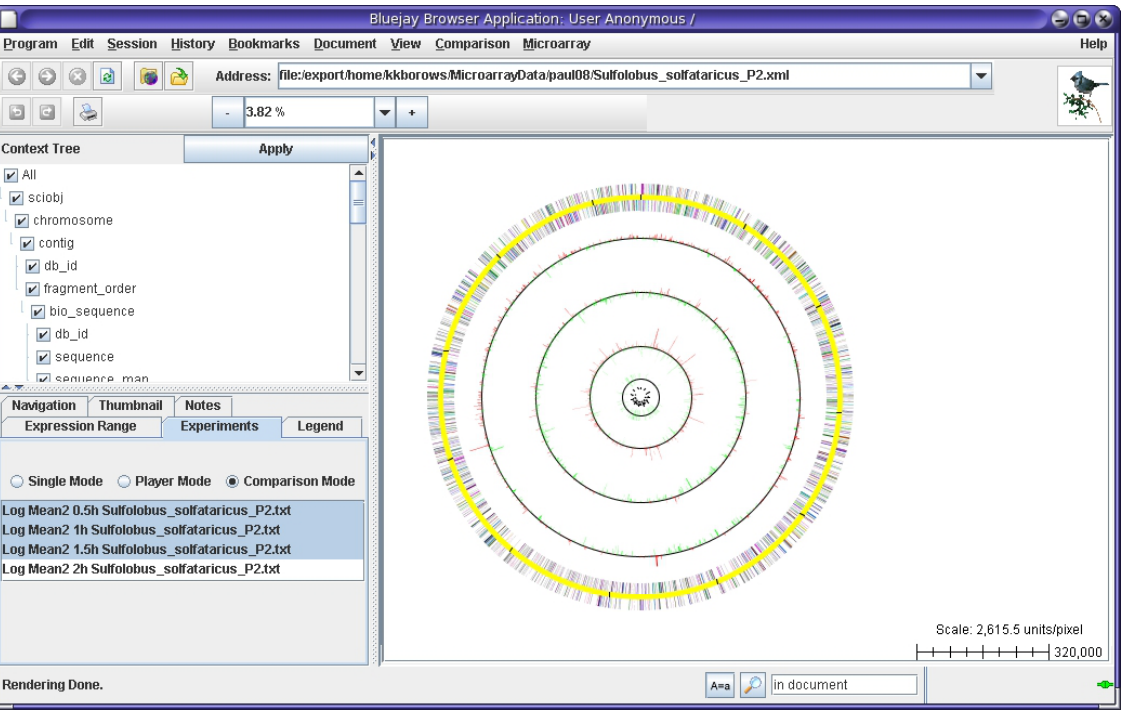
Figure 2: Multiple microarray data ( Sulfolobus solfataricus at di ff erent times after UV exposure) loaded in Bluejay and displayed simultaneously. Three di ff erent expression lanes corresponding to 0.5, 1, and 1.5 hours after UV exposure, respectively, are shown inside the Sulfolobus solfataricus